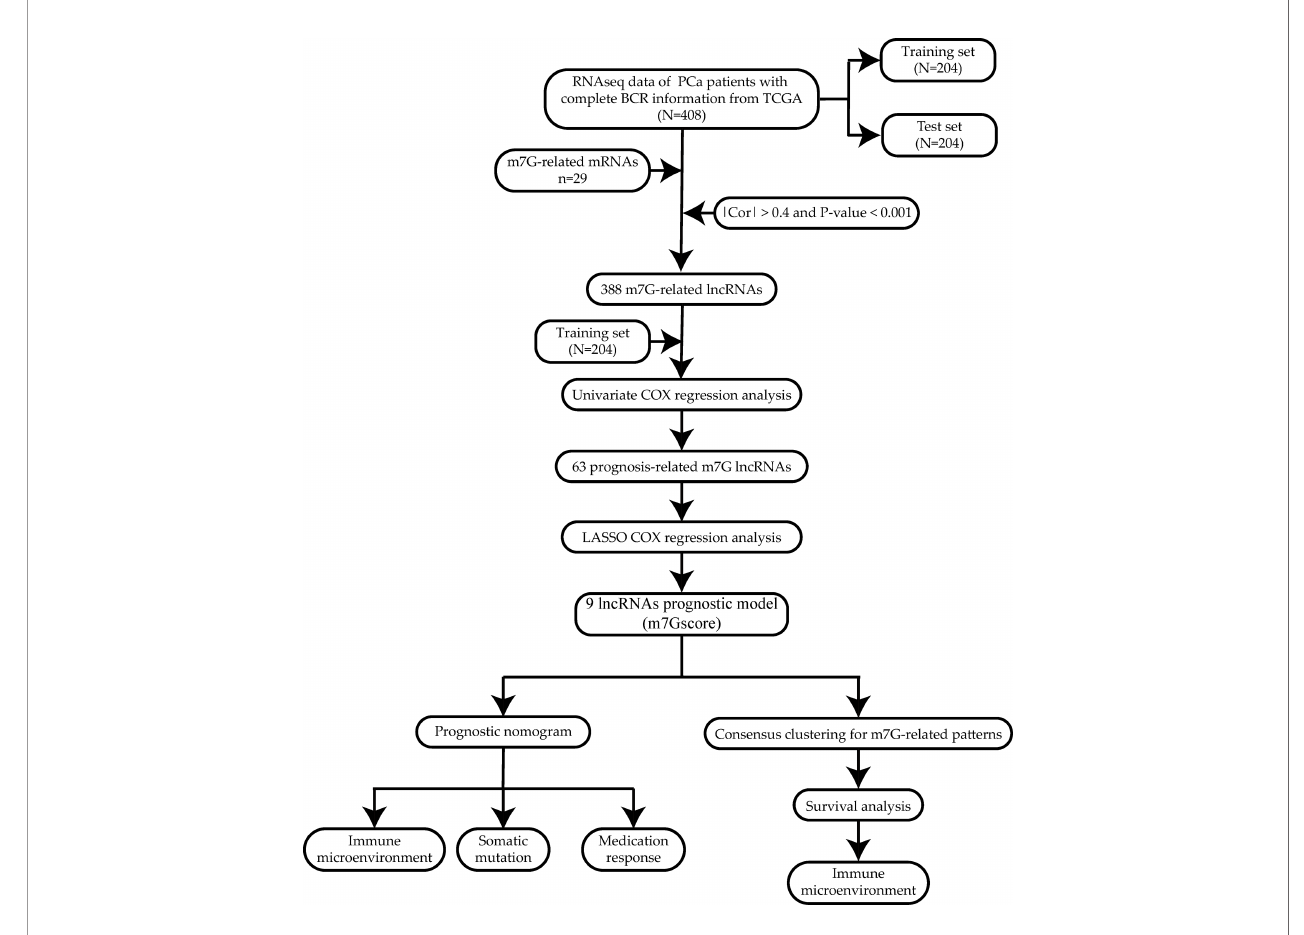
FIGURE 1 | Work fl ow of the